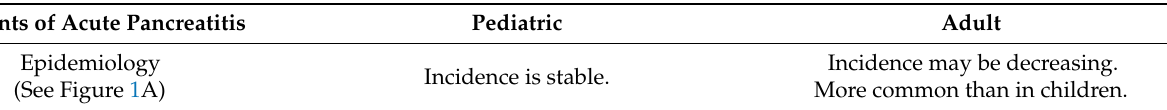
Table 1. Comparison of Acute Pancreatitis (AP) Epidemiology, Diagnosis, Contributing Factors, Management, Long Term Outcomes, and Areas for Research in Pediatric and Adult